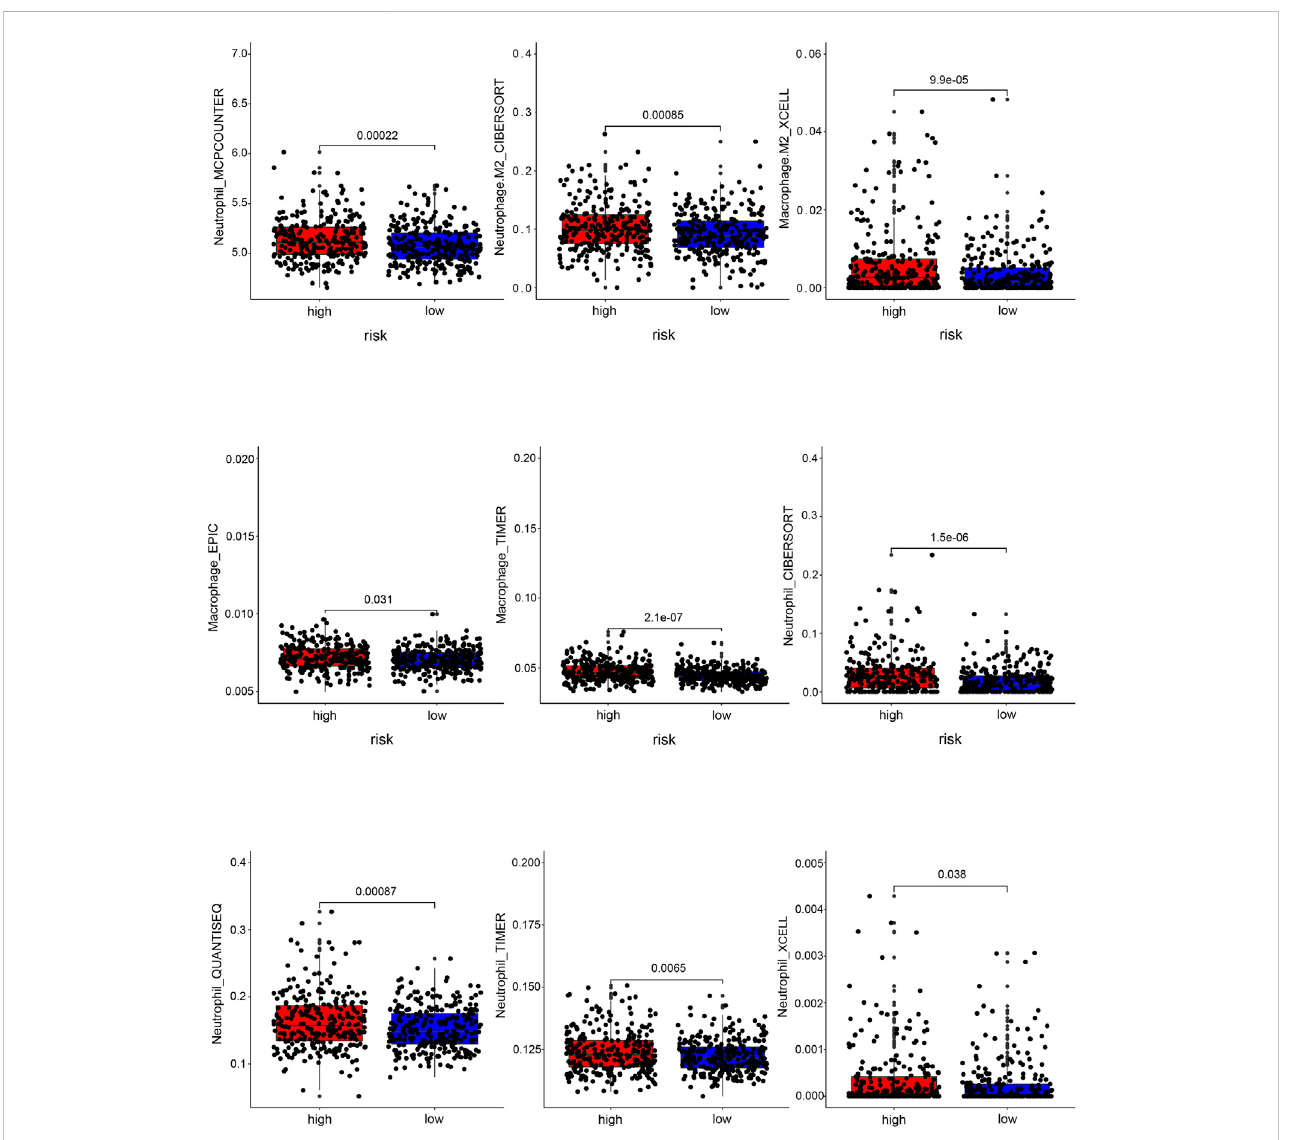
FIGURE 10 Correlation analysis between the risk score and immune cell in fi ltration. Box plots of immune cells with signi fi cant difference in high- and low-risk